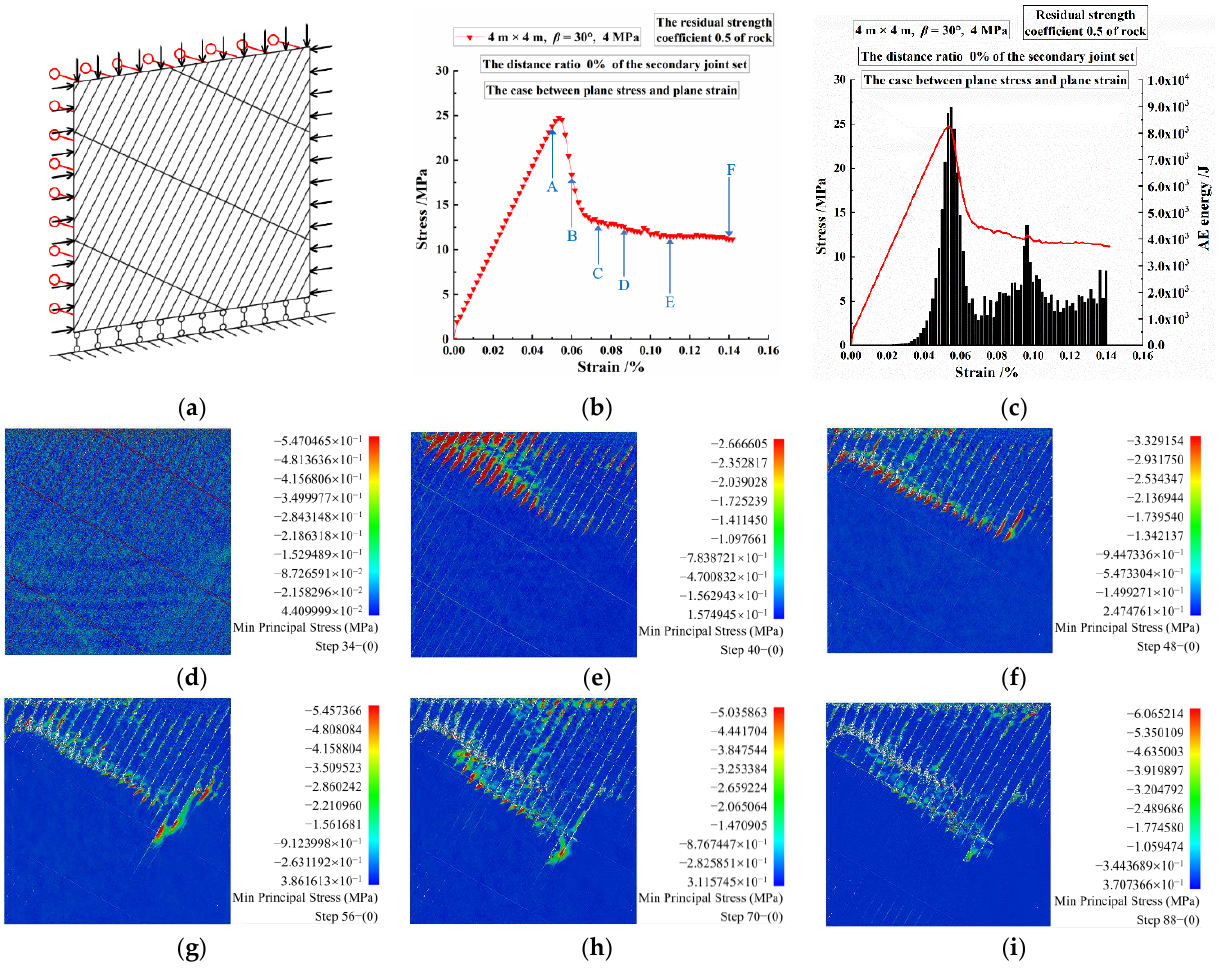
Figure 9. ( a ) For the case between plane stress and plane strain, the schematic diagram of the CJB model with β = 30° and the joint distance ratio 0%; ( b , c ) the loading curve and AE energy; ( d – i ) the minor principal stress contours at the Points A~F.